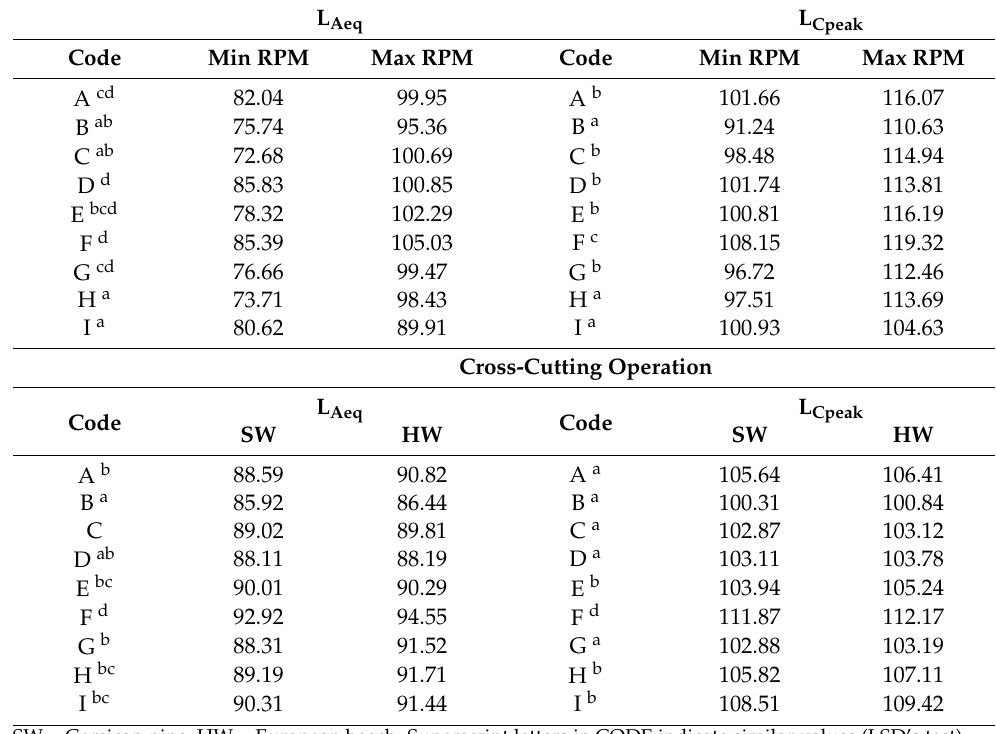
Table 3. Noise measurements in terms of L Aeq and LC peak